Question: Describe this figure in one sentence.
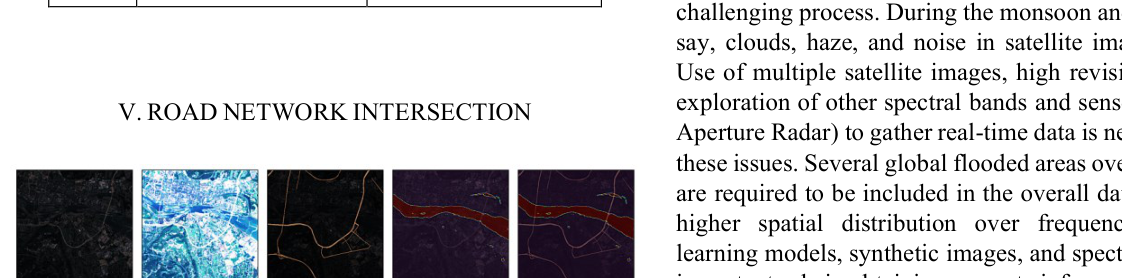
Answer: Plot for intersection between road networks in an  image and water bodies identified by the model.       The onboard computation which generates an image mask  with georeferencing data can be considered for processing on  an earth-based server where the geometric correction could be  first enhanced and an intersection of the water mask areas with  the road network can be analyzed. Figure 12 illustrates the same  concept. These areas are the ones that might have to be  formatted into data which can be made available for navigation  services to generate dynamic maps (e.g. GeoJSON format).      Some limitations of the existing  method are worth  highlighting. Cloud effects can obviously mask certain areas of  study and the dataset is best augmented with a cloud mask in  the next iteration. It can be challenging to identify flood  intersections on underpass roads invisible to the satellite  imagery, and on roads that have greater vegetation.  Furthermore, there is little attention